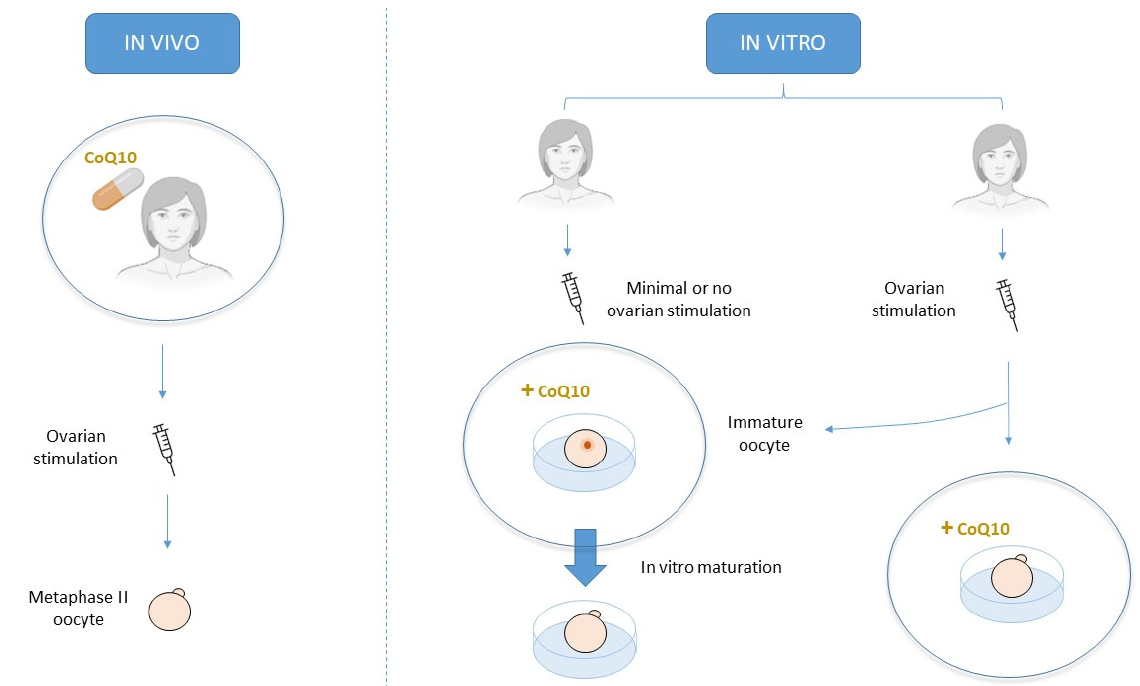
Figure 4. Schematic description of the main three approaches for CoQ10 treatment. Oral preovulatory CoQ10 treatment exerts positive effects on the ovaries of aged